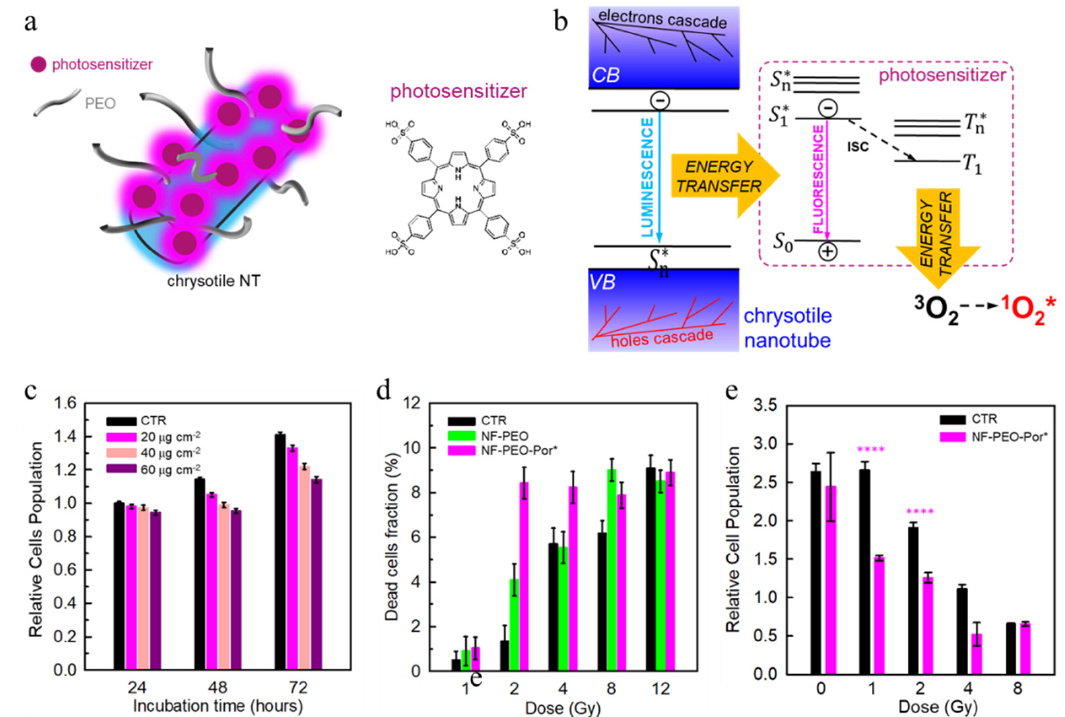
Figure 5. ( a ) Sketch of the hybrid nanoscintillator composed based on a chrysotile nanotube (NT) functionalized with and H 2 TPPS 4 − porphyrin (Por*) as singlet oxygen photosensitizer and PEO as stabilizer for colloidal dispersion (NT-PEO-Por*). ( b ) Outline of the photophysical process involved in the sensitization of singlet oxygen ( 1 O 2 *) production upon irradiation with X-rays. Free electrons and holes generated by interaction with the ionizing radiation in the NT localize at an emissive state that transfers its energy to the photosensitizer molecules on the surface promoting their excited singlet state (S 1 *). Upon intersystem crossing (ISC), the energy is transferred from the photosensitizer triplet to the dispersed molecular oxygen in triplet ground-state 3 O 2 , which is promoted to its excited singlet state. ( c ) Evaluation of cell metabolic activity by the MTT test on U-87 cells stained with 20, 40, and 60 µ g cm − 2 of NT-PEO-Por*. ( d ) Relative fraction of dead cells estimated by the Trypan blue cell exclusion assay on U-87cells stained with 20 µ g cm − 2 of NT-PEO-Por* as a function of the nominal dose delivered. ( e ) Evaluation of cell metabolic activity by the MTT test on U-87 cells stained with 20 µ g cm − 2 of NT-PEO-Por* as a function of the nominal dose delivered. MTT assays and Trypan blue cell counting were performed in triplicate. Statistical analysis: two-way ANOVA, p < 0.0001 ****. Error bars are the standard deviations of the mean values calculated for five independent experiments. Reproduced with permission from ACS Appl. Mater. Interfaces 2021, 13, 11